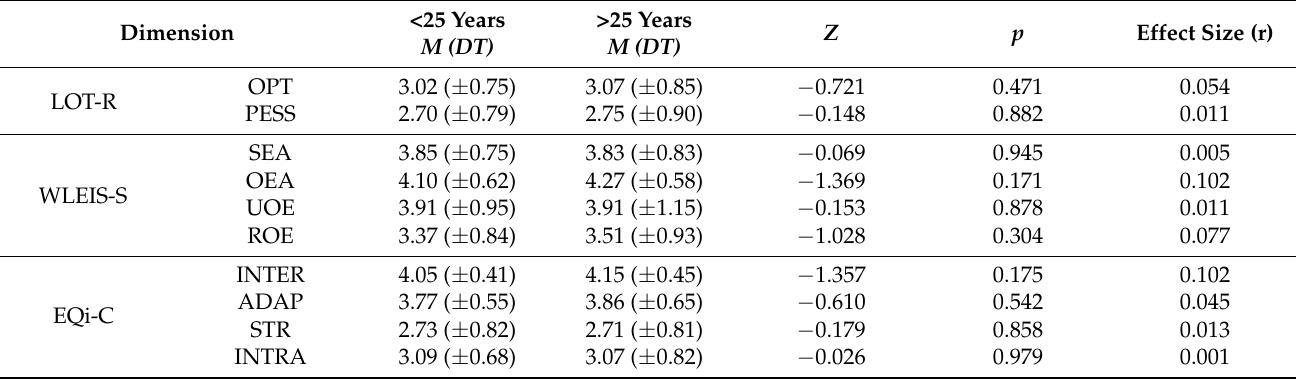
Table 2. Mean differences according to age ( U of Mann–Whitney).